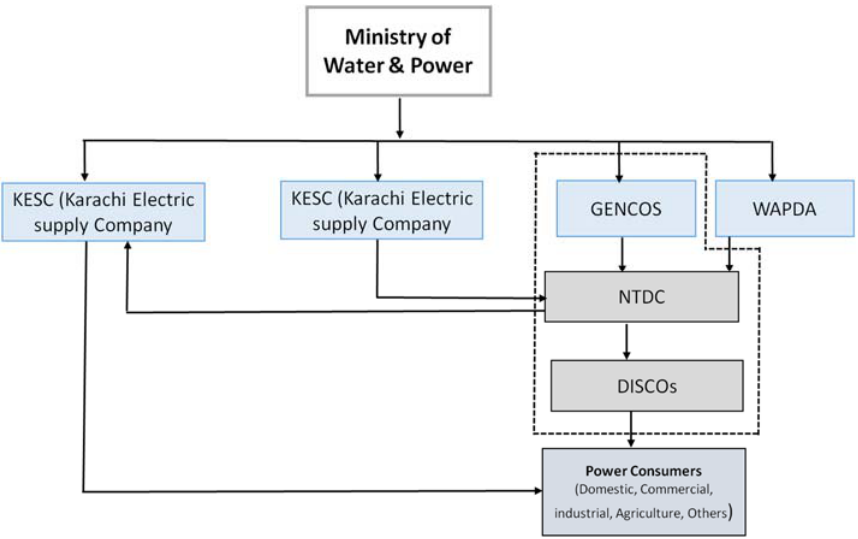
Figure 4. An illustrative outlook of the electric power division of Pakistan.